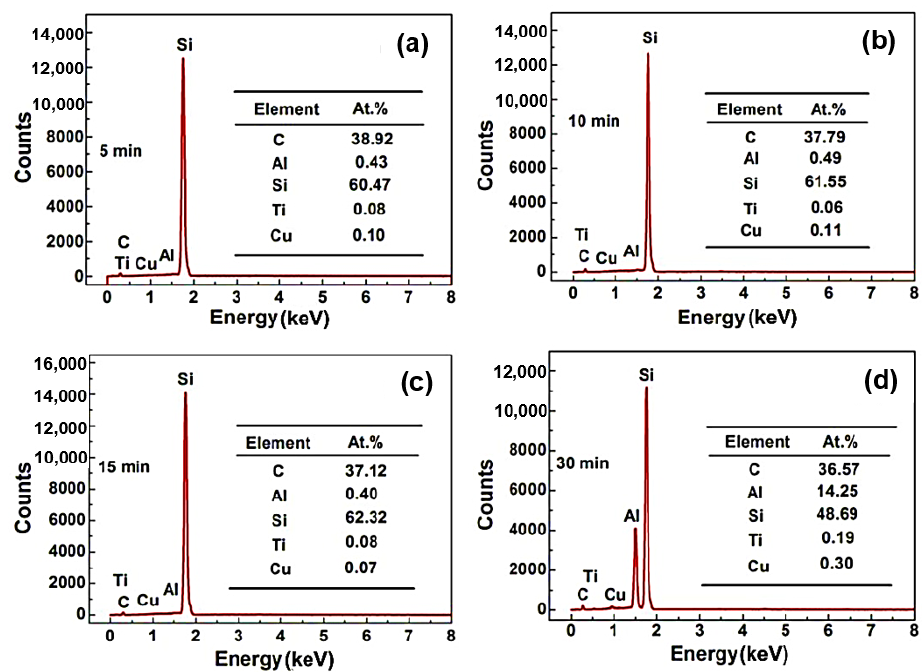
Figure 4. EDS analysis of SiC ceramic inner areas infiltrated at 900 °C for different time: ( a ) 5 min, ( b ) 10 min, ( c ) 15 min, and ( d ) 30 min.